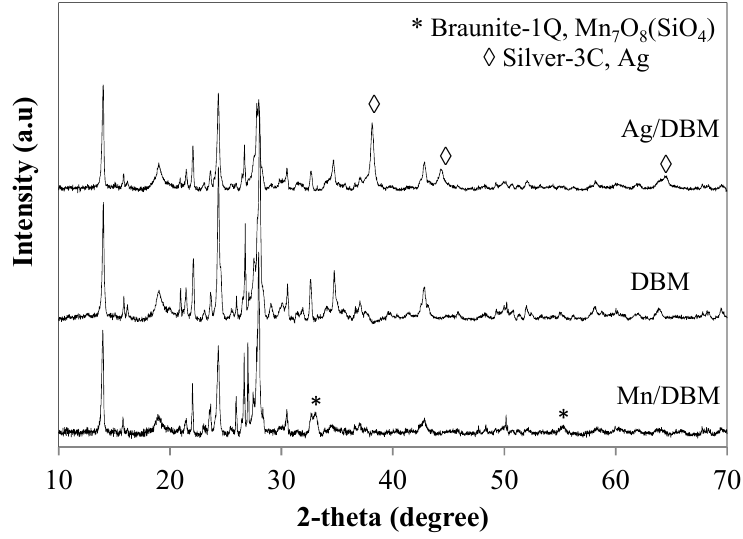
ff ractograms of DBM, Ag / DBM, and Mn / DBM Figure 10. Diffractograms of DBM, Ag/DBM, and Mn/DBM catalysts. Figure 10. Di